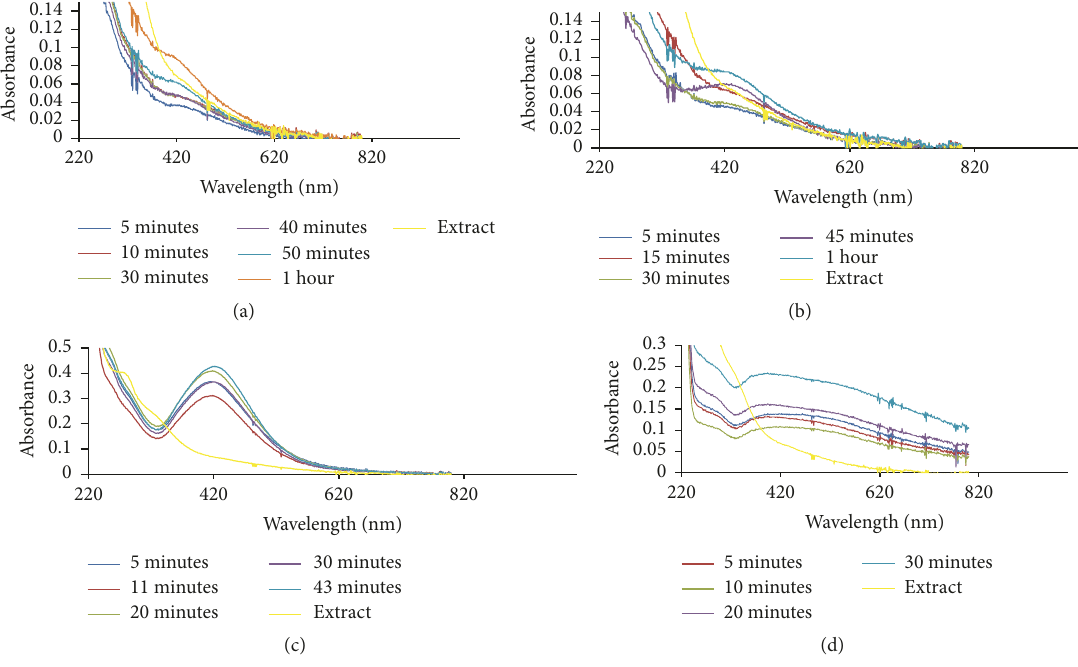
Extract00.050.10.150.20.250.30.350.4 A b